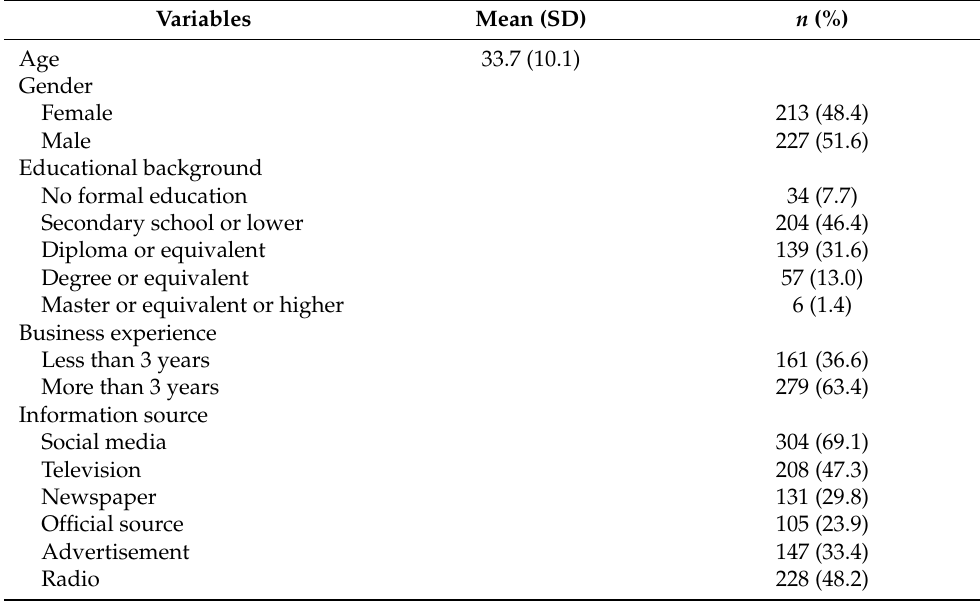
Table 1. Night market street food hawkers’ sociodemographic background in the context of support-